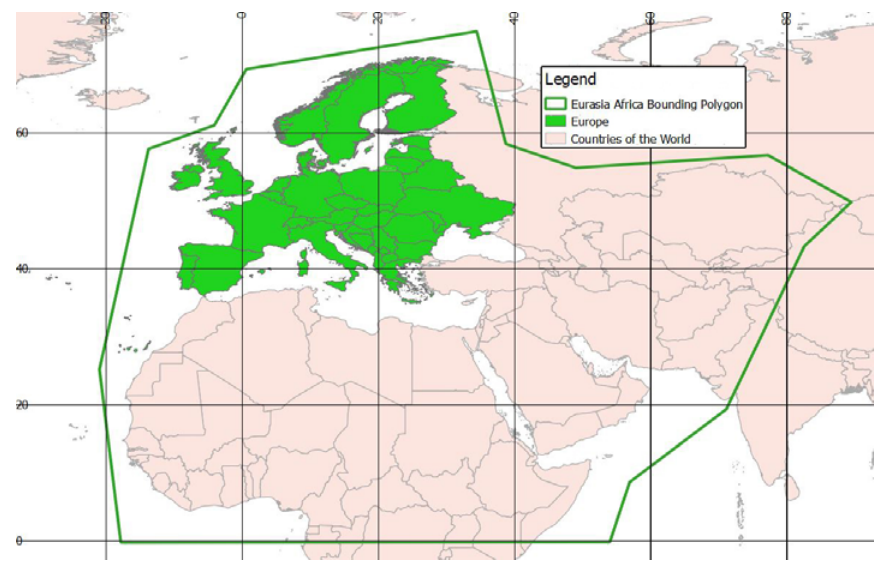
Figure 4. Spatial filter applied to tweets.